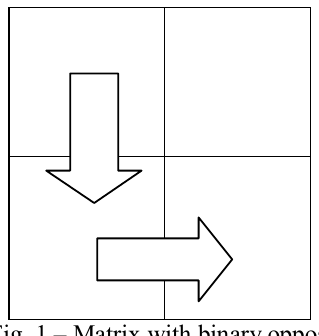
Fig. 1 – Matrix with binary